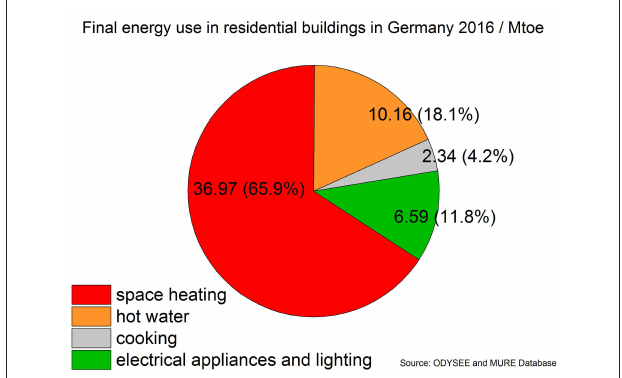
FIGURE 1 | Final energy use in residential buildings in Germany 2016 in Mtoe and (percentage share). Graph based on data from the ODYSEE MURE Database